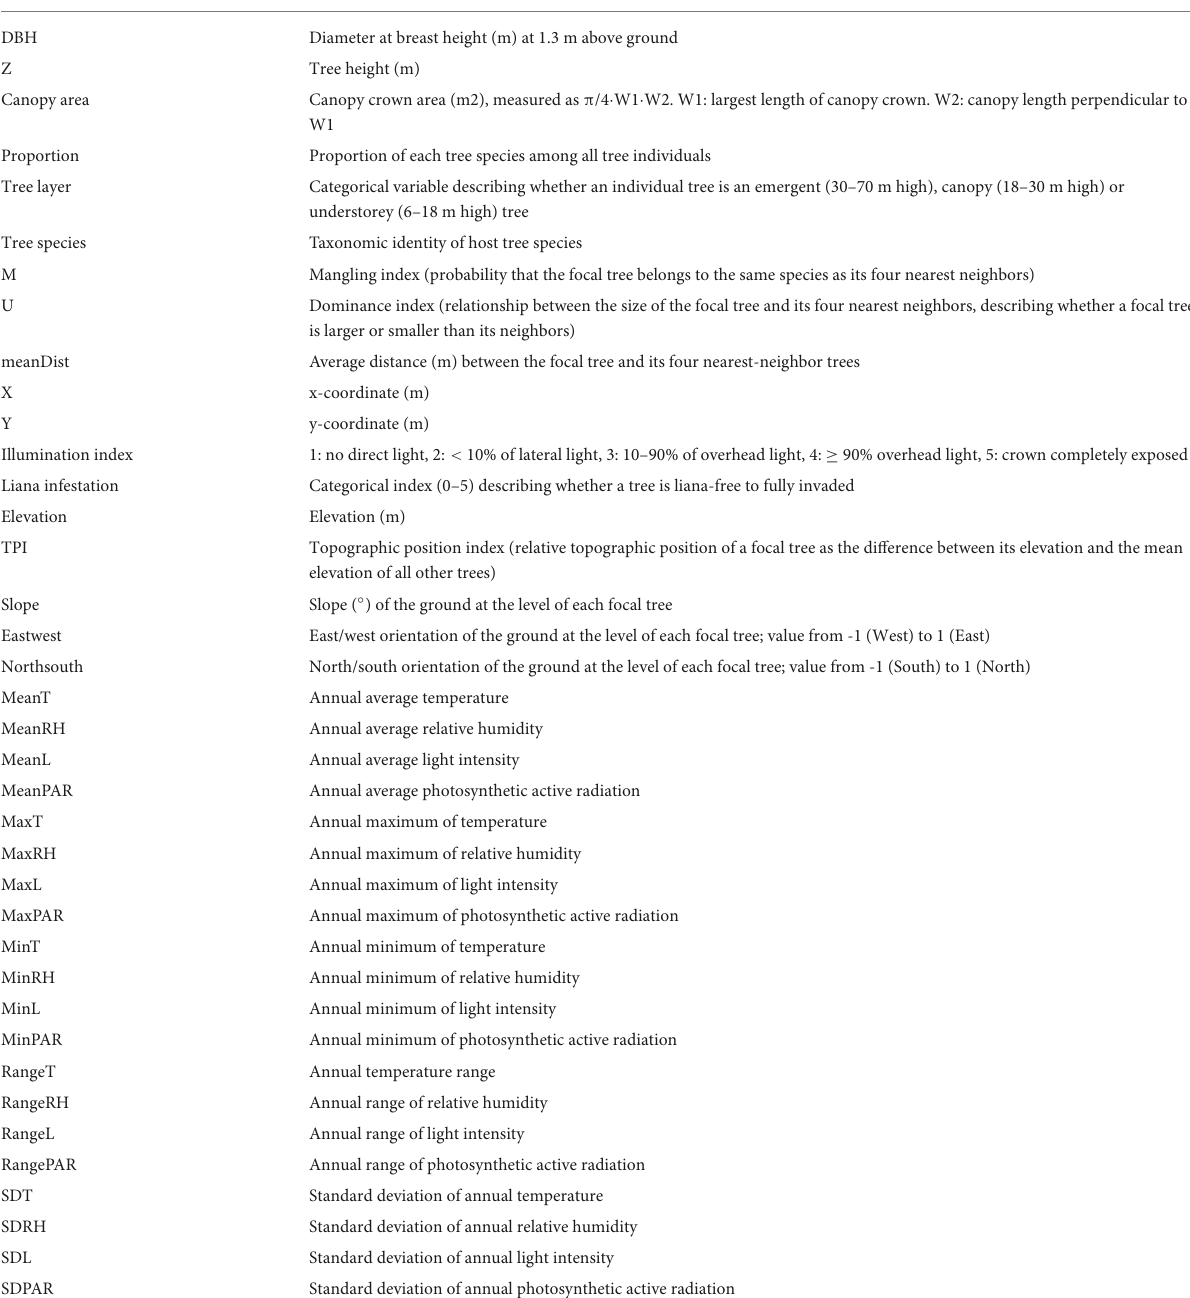
TABLE 1 Environmental variables used to predict the probability of occurrence, species richness and abundance of epiphytic spermatophytes and ferns on individual trees in a 1.1 ha tropical rainforest (Yunnan, SW China). Environmental